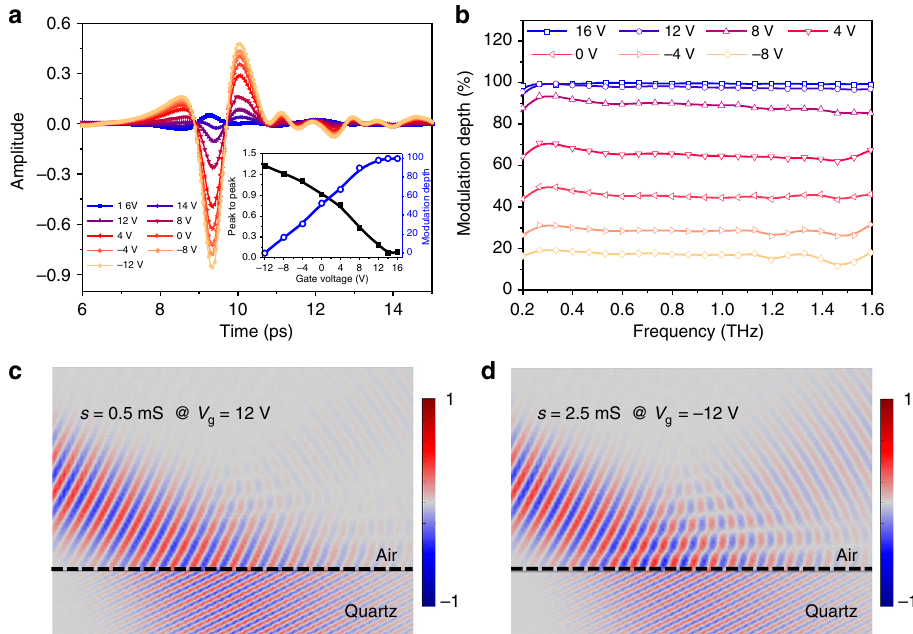
Fig. 3 The device operates as a THz intensity modulator, when the incident angle is 65°. a Re fl ected THz signal in a time domain. b The modulation depth as a function of frequency. The simulated E - fi eld with a conductivity of ( c ) 0.5 mS, and ( d ) 2.5 mS under the incident angle of 65°. The dashed line presents the graphene on quartz